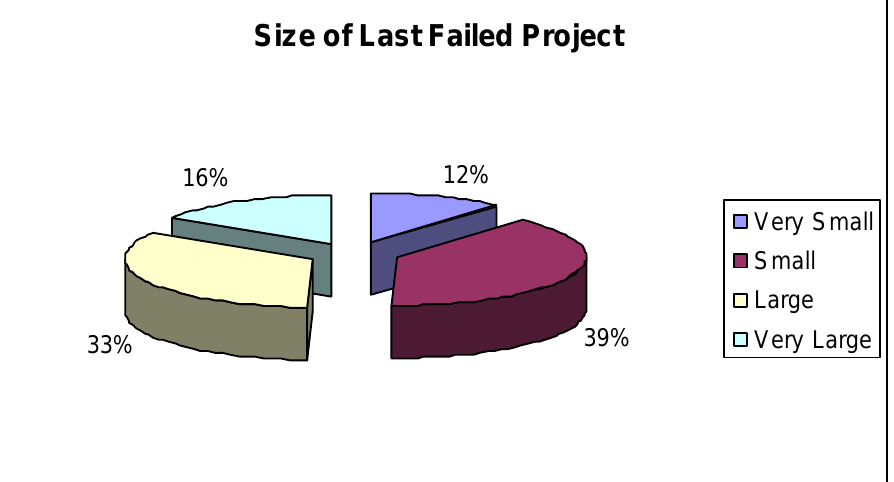
Figure 2: Size of last failed project